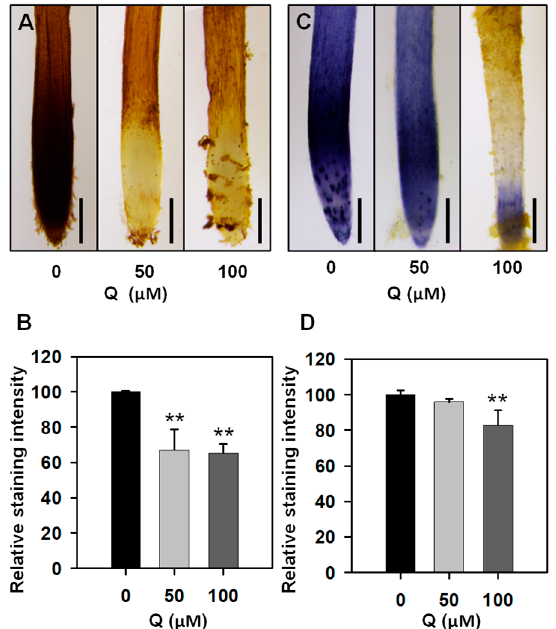
Figure 2. Reactive oxygen species (ROS) accumulation in the primary root tips with or without quercetin treatment. ( A ) The 3,3-diaminobenzidine (DAB) staining for H 2 O 2 in the rice primary root tips with or without quercetin treatment. Experiments were repeated three times with similar results. Three to six roots were used for each experiment. Bars = 200 µ m. ( B ) The DAB staining intensity in the rice primary root tips was determined with ImageJ. ( C ) NBT staining for O 2 − in rice primary root tips with or without quercetin treatment. Experiments were repeated three times with similar results. Three to six roots were used for each experiment. Bars = 200 µ m. ( D ) The nitro blue tetrazolium (NBT) staining intensity in the rice primary root tips was determined with ImageJ. The asterisks in ( B , D ) indicate the differences between the untreated and quercetin-treated rice root tips (Student t test, ** p < 0.01).